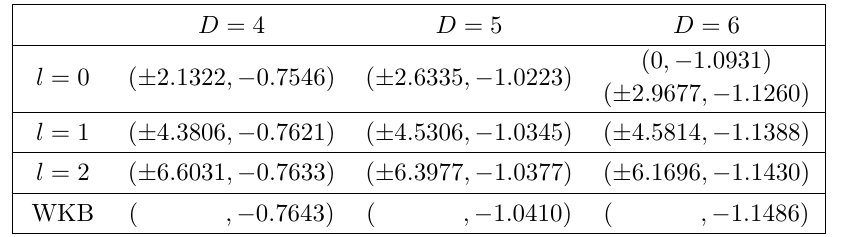
Table 1 . The low-lying spectrum of quasinormal modes ! Q = 0 : 996. Q max